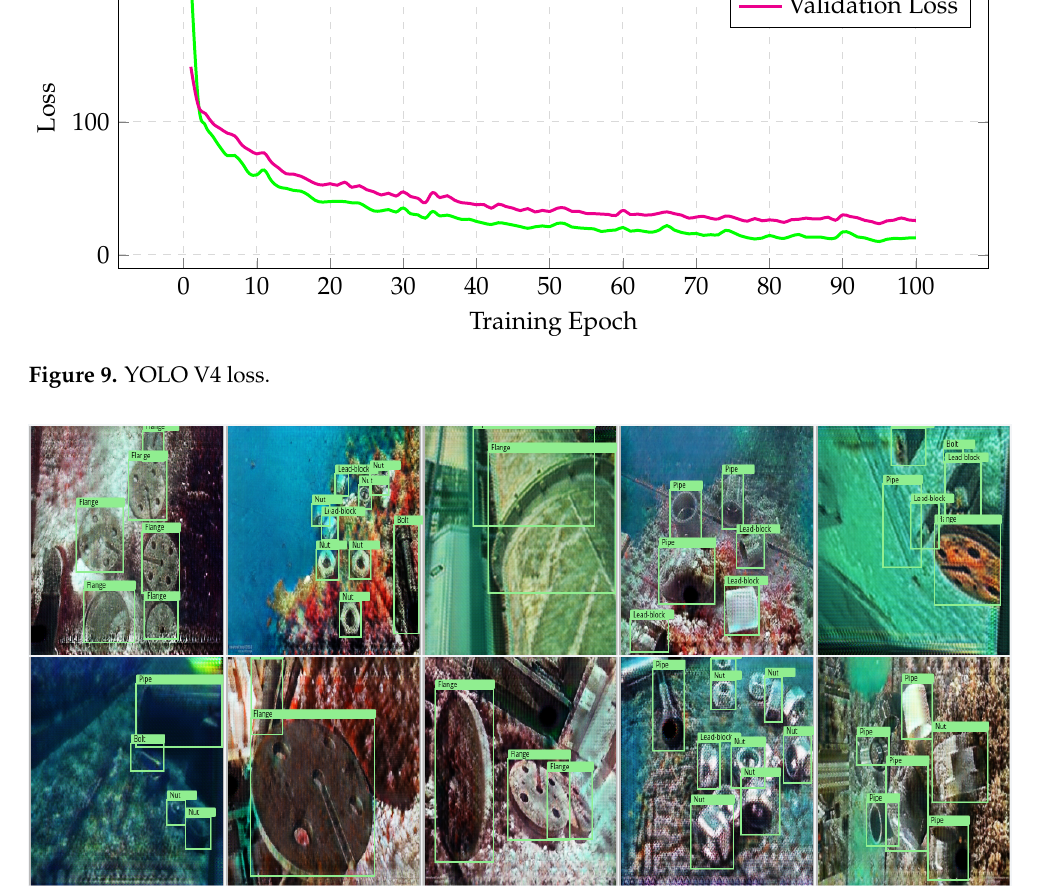
Figure 10. YOLO object